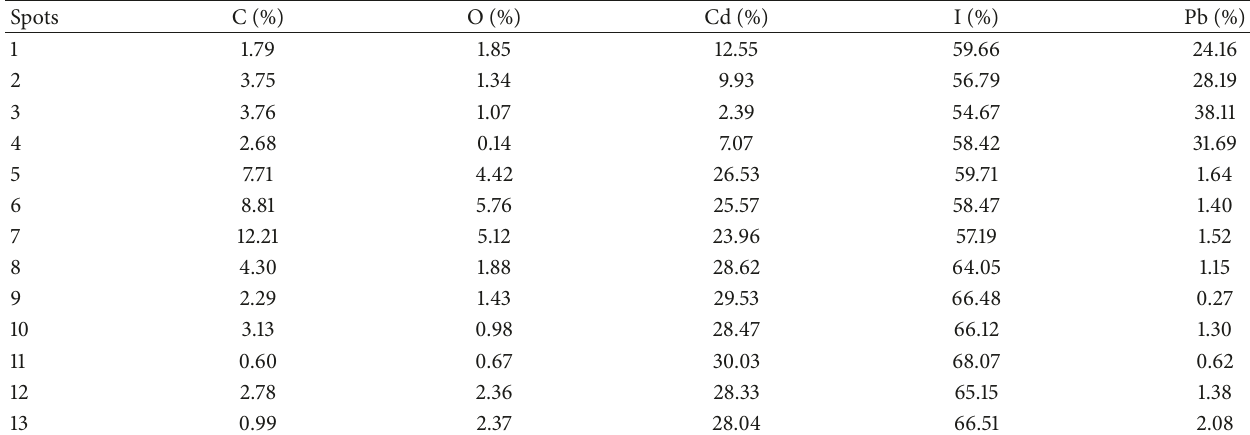
Figure 1: XRD spectrum of PbCdI 2 thick film. Table 1: Chemical composition of PbCdI 2 film, obtained for spots 1–13, shown in Figure